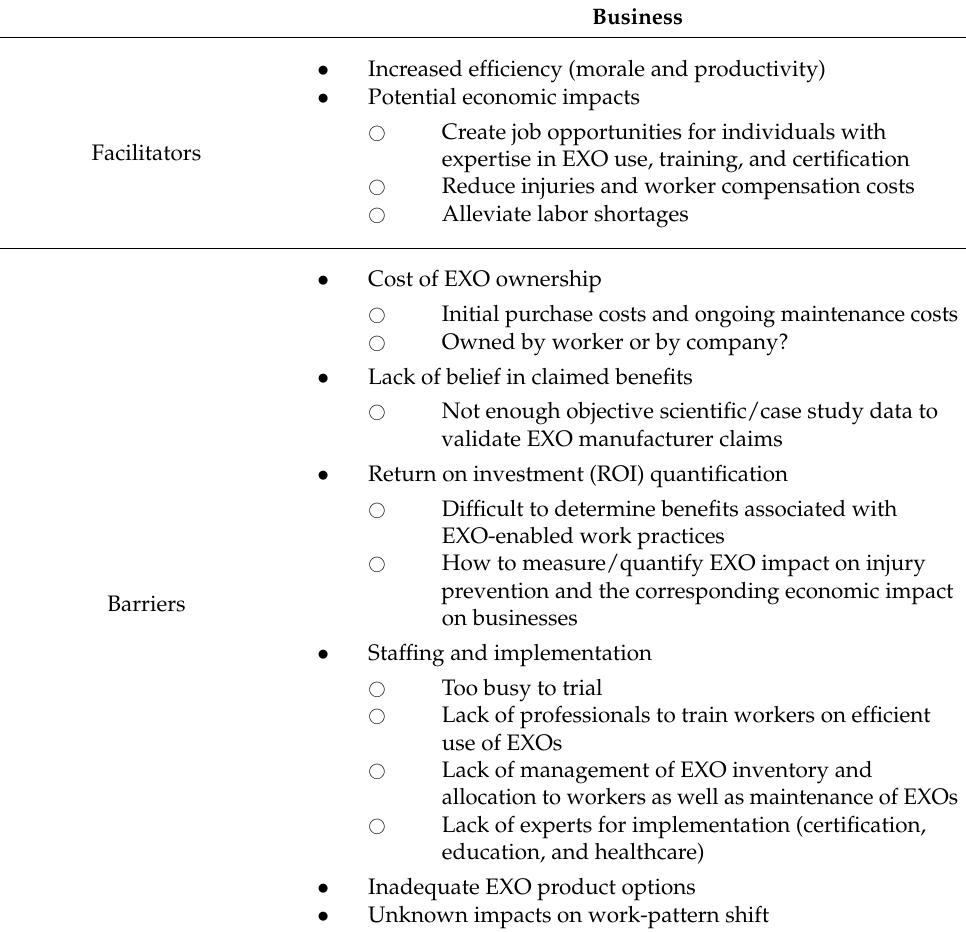
Table 3. Summary of business category